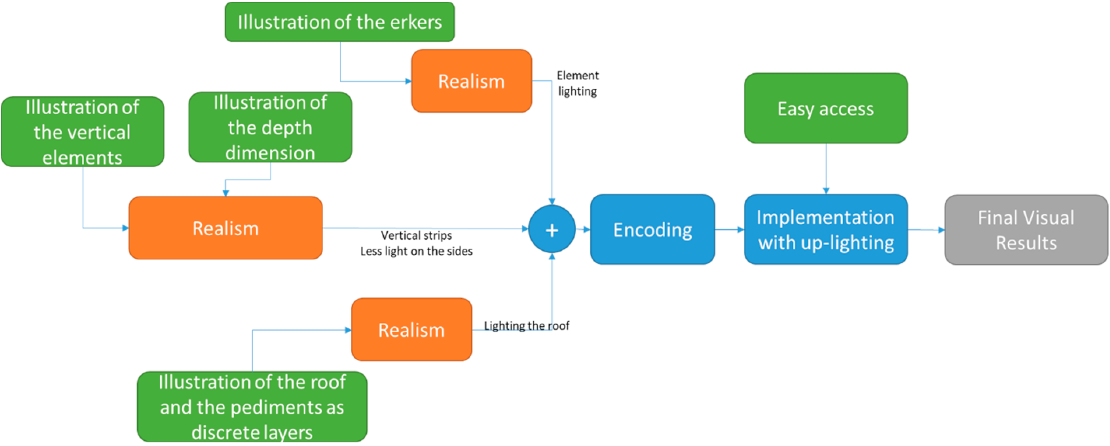
Figure 16. Simulation of visual result of Working Diagram II—Scene 3.